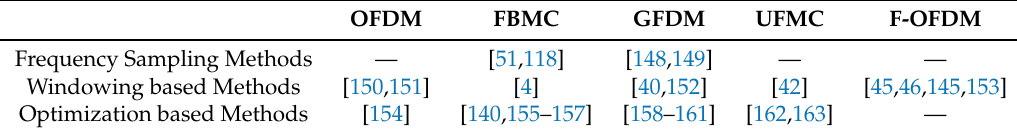
Table 7. Summary of filter design methods used in existing multicarrier modulation